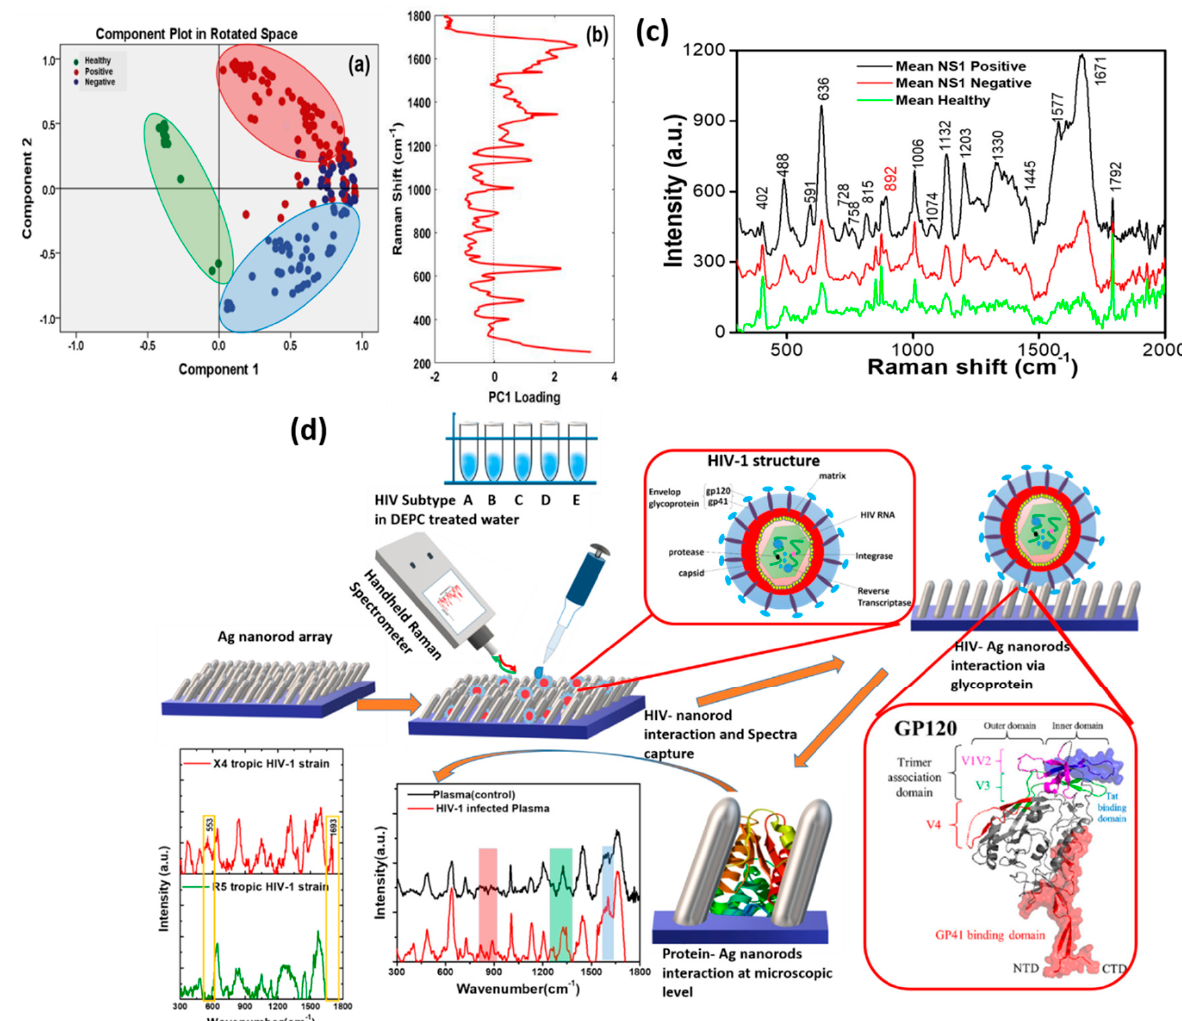
Figure 9. ( a ) Figure showing principal component 1 versus principal component 2 for three different groups of samples (antigen NS1-positive, -negative, and healthy). ( b ) Graph showing Raman shifts with the PC1 loading of plot ( a ). ( c ) SERS spectra obtained for the healthy, NS1-negative, and NS1- positive sera collected from the patients (each spectrum is an average of 20 spectra). Reproduced with permission from [36]. ( d ) Schematic diagram showing rapid handheld SERS platform for early HIV detection. Reproduced with permission from